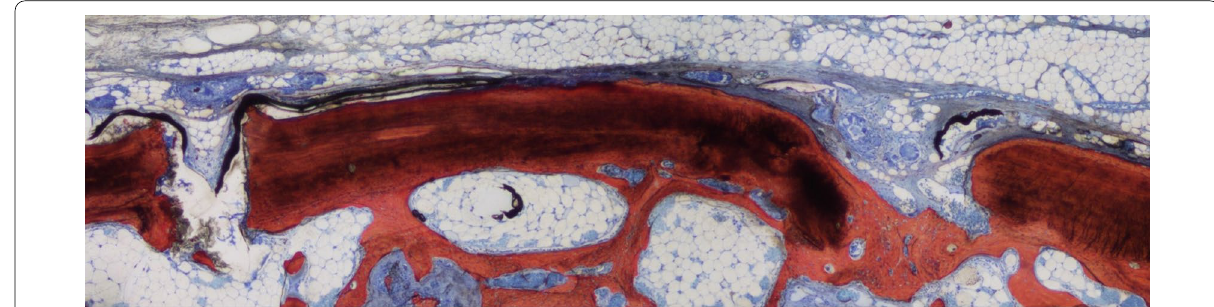
Fig. 2 Ground section representing the healing after 8 weeks. New bone continued to increase in proportion both at test and control (not shown) site in the antrostomy region. Original magnification 100. Stevenel´s blue and alizarin red stain. From Omori et al. ×